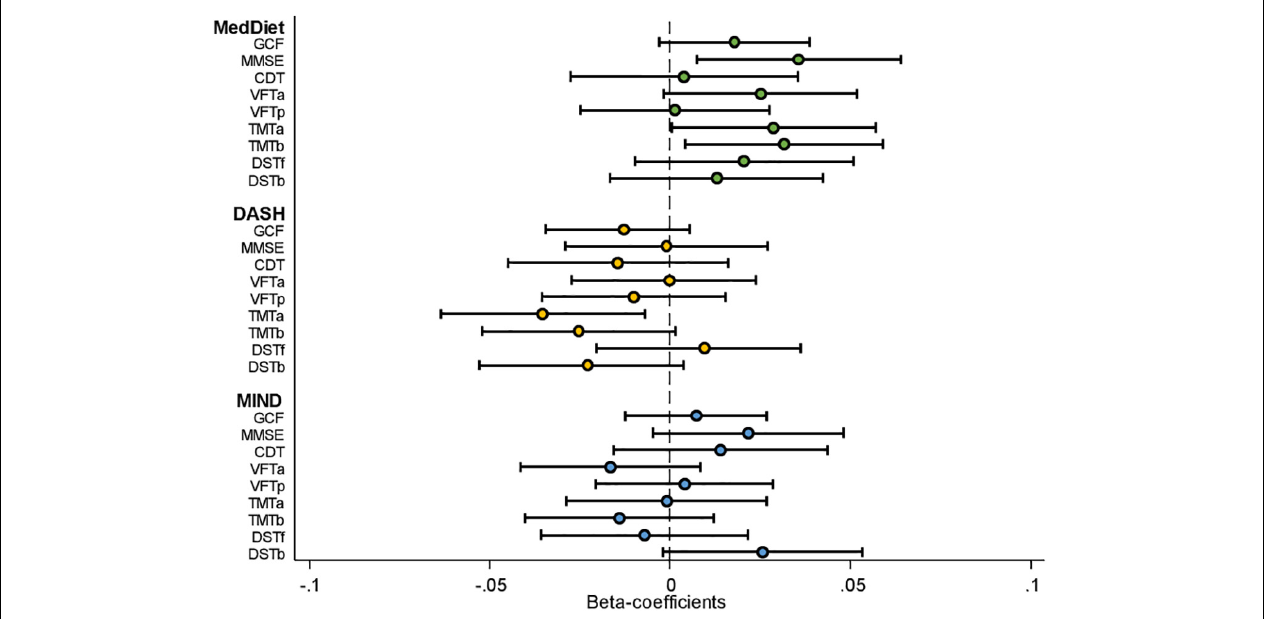
FIGURE 2 | Cognitive function assessment by dietary pattern adherence [standardized beta-coefficients (95% confidence intervals)]. CDT; clock drawing test; DASH; Dietary Approaches to Stop Hypertension; DST-b, digit span test backward; DST-f, digit span test forward; GCF, global cognitive function; MedDiet, Mediterranean dietary pattern; MIND; Mediterranean-DASH Intervention for Neurodegenerative Delay; MMSE, Mini-Mental State Examination; TMT-A, Trail Making Test Part A; TMT-B, Trail Making Test Part B; VFT-a; verbal fluency tasks semantical; VFT-b; verbal fluency tasks phonological. Model presented adjusted for age (in Years), sex, intervention group, centre size ( < 250, 250 to < 300, 300 to < 400, ≥ 400), respective cognitive test score at baseline, baseline education level (primary school, secondary school collage), civil status (single, divorced, or separated, married, and windower), smoking habits (smoker, former smoker, and never smoked), corrected for clusters (to account for couples living in the same household being randomized as a single unit), BMI (kg/m 2 ), hypertension (yes/no), baseline physical activity (MET min/week) and total energy intake (kcal/day). For the neurological tests, a positive beta-coefficient value in the figure indicates better cognitive performance according to the associated